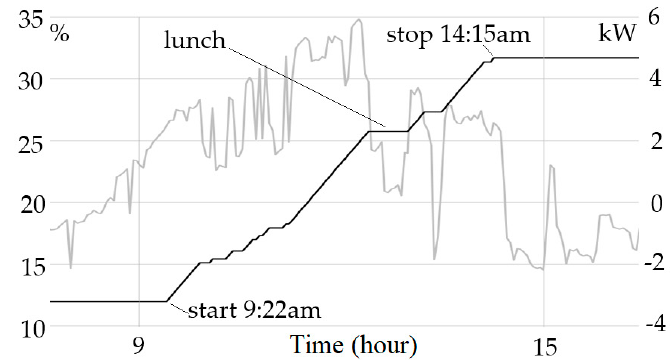
Figure 11. The state of charge of Nissan Leaf batteries.